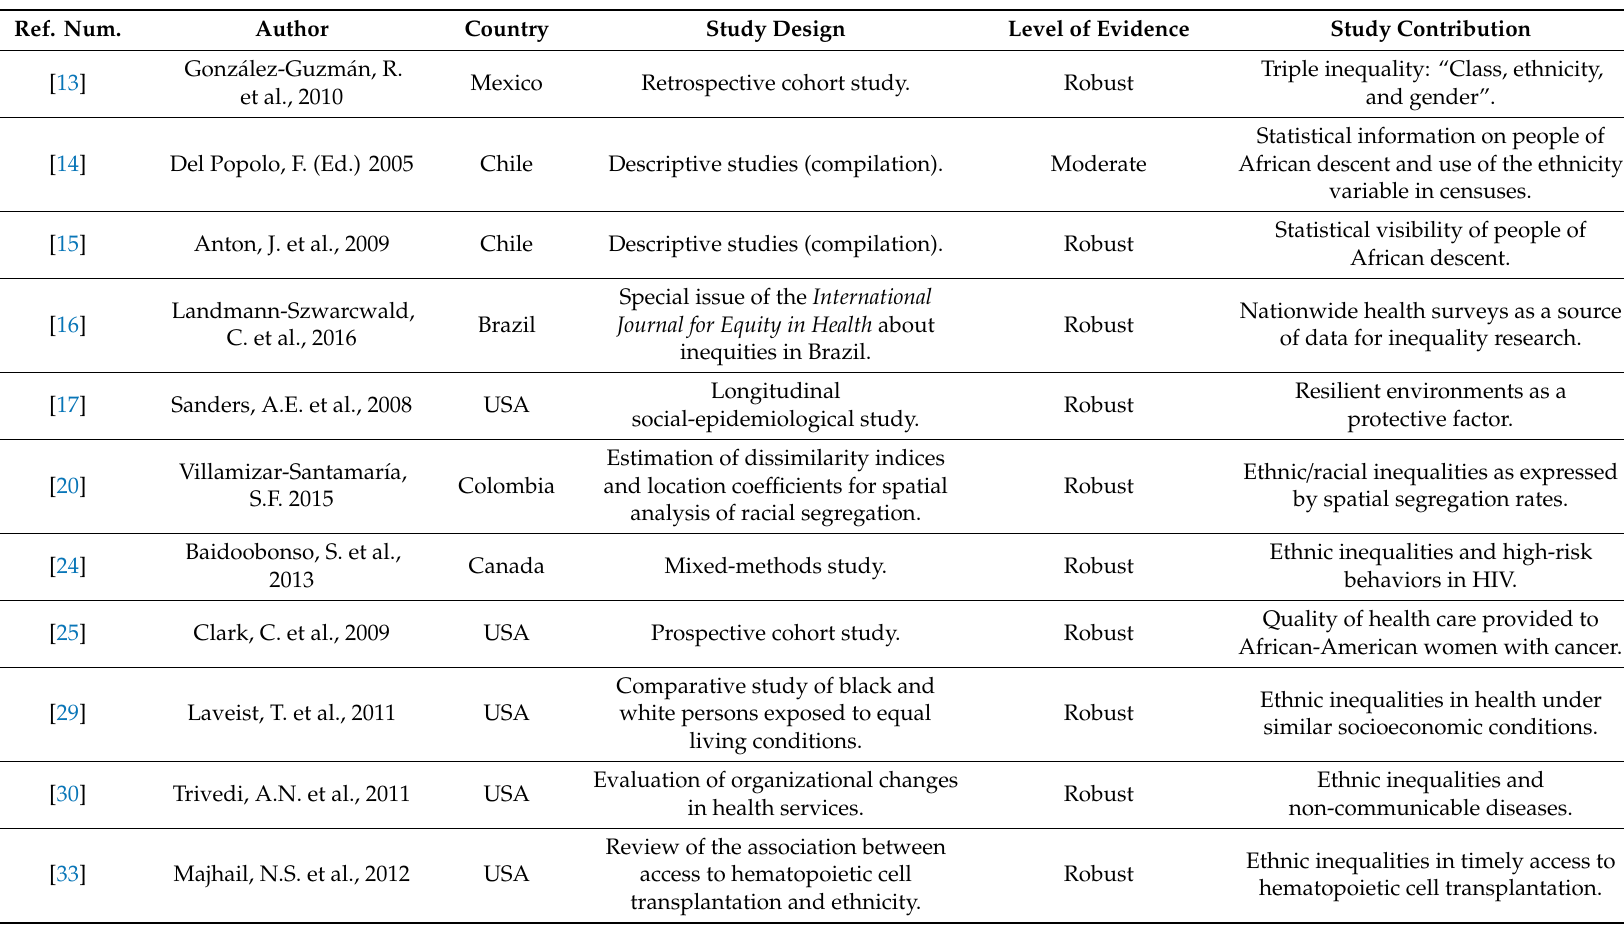
Table 4. Relevant quantitative studies and their contributions to understanding health inequalities among people of African descent in the Americas. Ref.